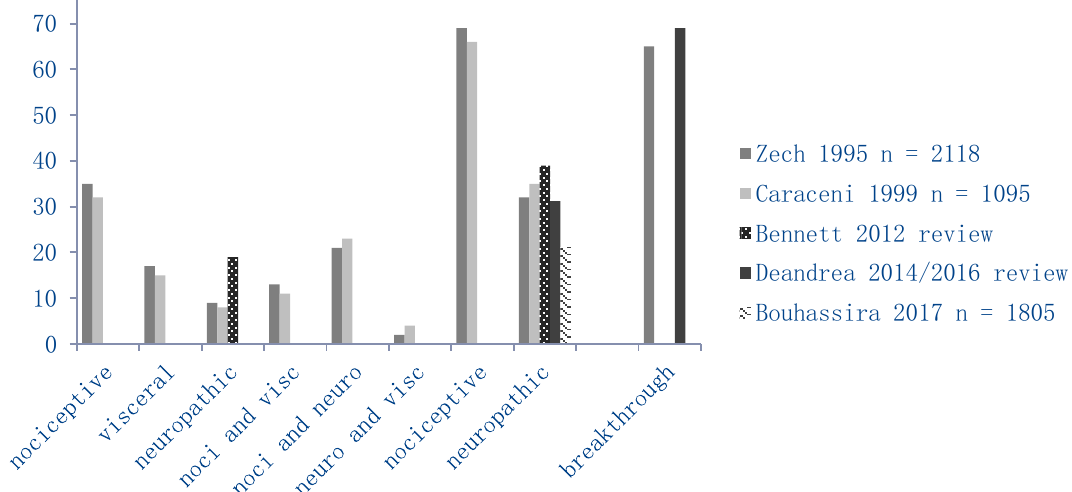
Figure 1. Prevalence (in %) of different pain modalities in cancer, as reported by various studies.